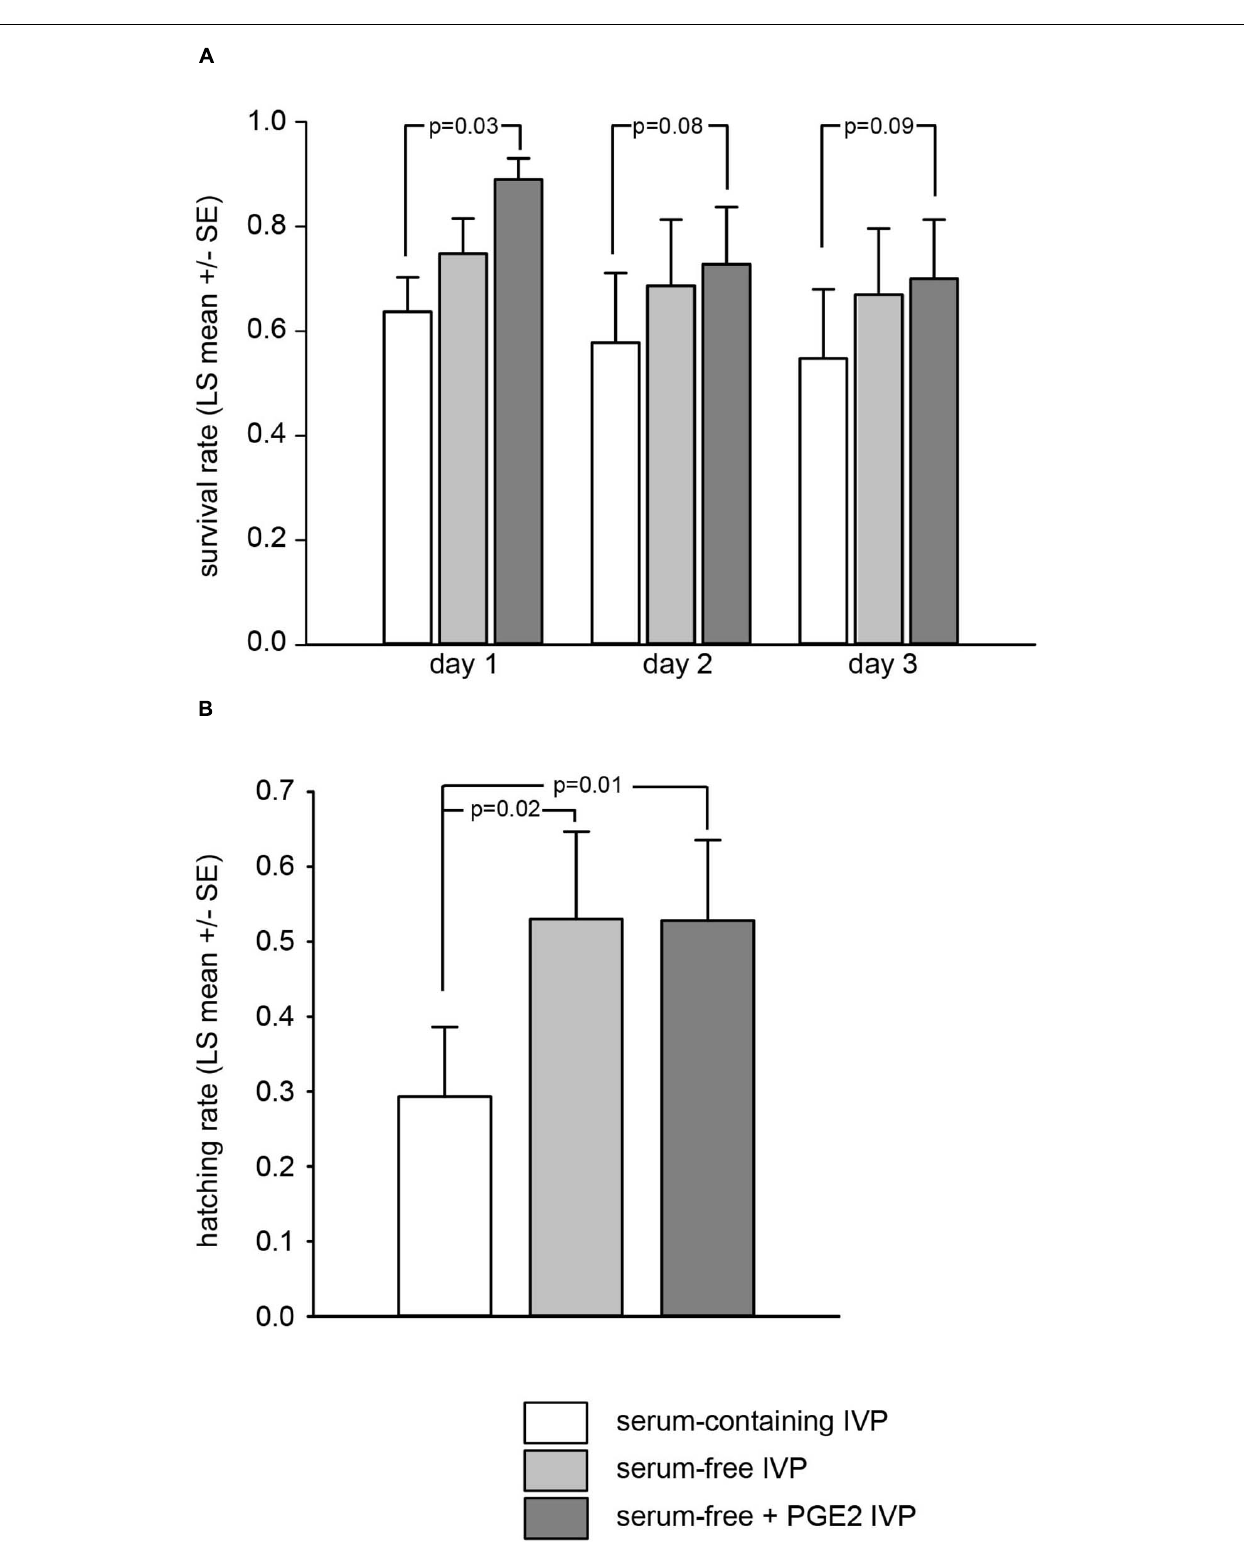
Frontiers in Cell and Developmental Biology |